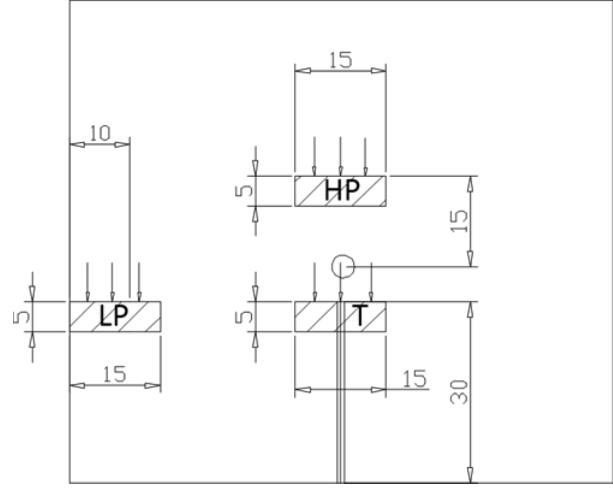
Figure 8. Identification of the zones subjected to metallurgical testing, T (Thermocouple), HP (High Pressure), and LP (Low Pressure).